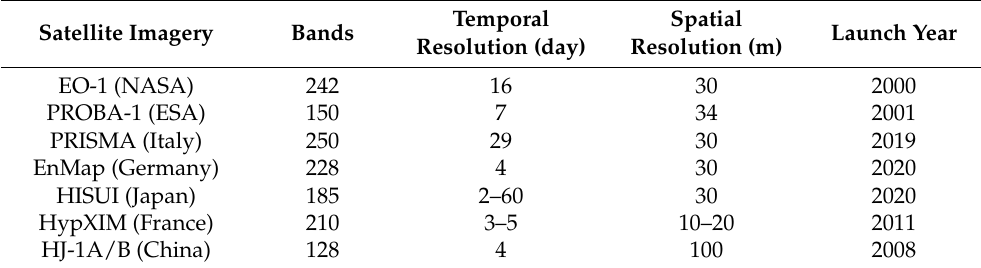
Table 4. Commonly used hyperspectral satellite